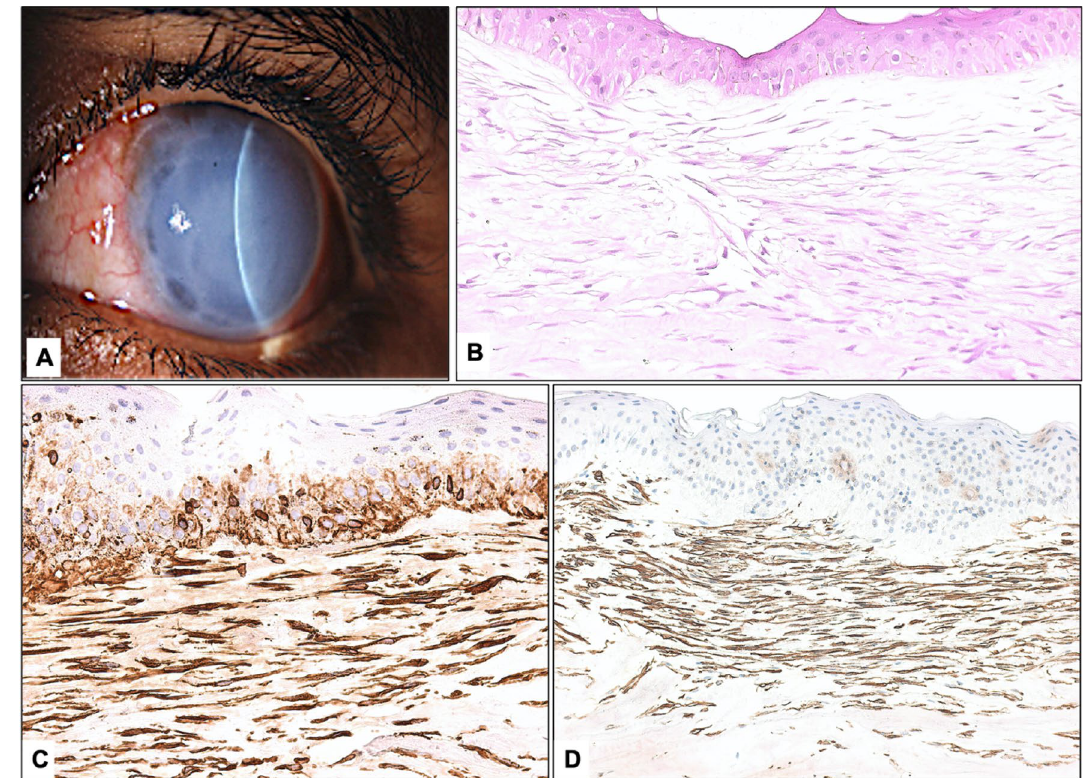
Figure 3. ( A ) The clinical appearance of case 7 with the diagnosis of Peter’s anomaly represents a case of secondary-developmental-myxoma (ASD-associated). ( B ) The corresponding histopathological appearance of the incidental associated corneal subepithelial myxoma shows absent Bowman’s layer and the typical spindle- shaped cells (× 400 magnification, Hematoxylin and Eosin). ( C ) The positive reactivity of the spindle cells of the same lesion to the immunohistochemical staining for Vimentin. ( D ) A similar reactivity to smooth muscle actin in contrast to the above secondary-truly acquired-myxoma (Case 6) with an absent expression of smooth muscle actin implicating different pathogenesis between the 2 groups (× 400 magnification).